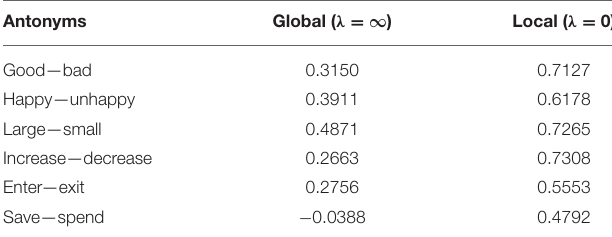
TABLE 7 | Cosine similarity of antonym embeddings trained with different contexts.